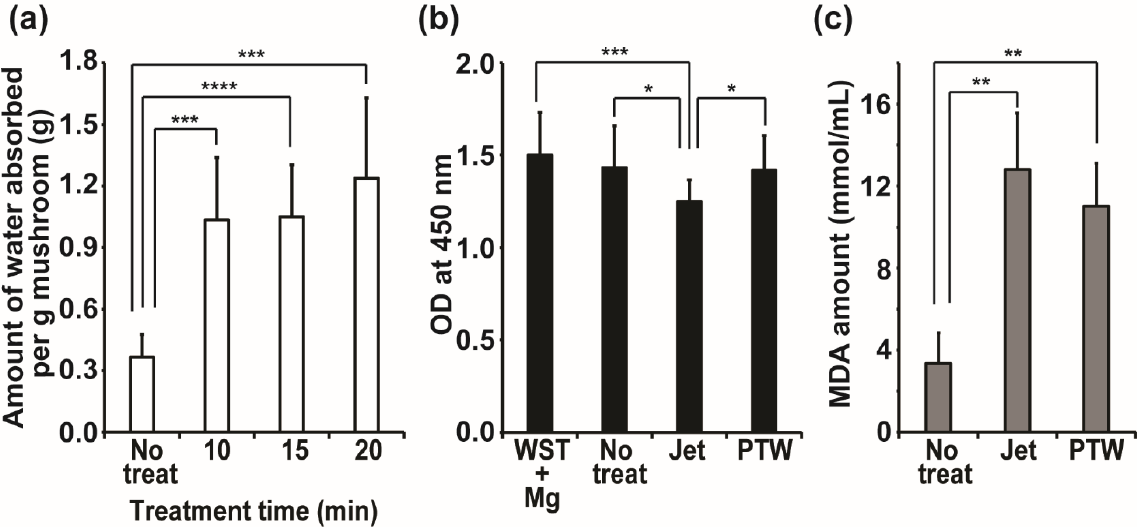
Figure 6. Hydrophilicity ( a ), redox potential ( b ), and lipid peroxidation of bacteria ( c ) on the surfaces of mushrooms. Values were the average of 12, 19, and 6 measurements in ( a ), ( b ), and ( c ), respectively. Only significantly different groups were indicated; * p < 0.05, ** p < 0.01, *** p < 0.001, **** p < 0.0001.